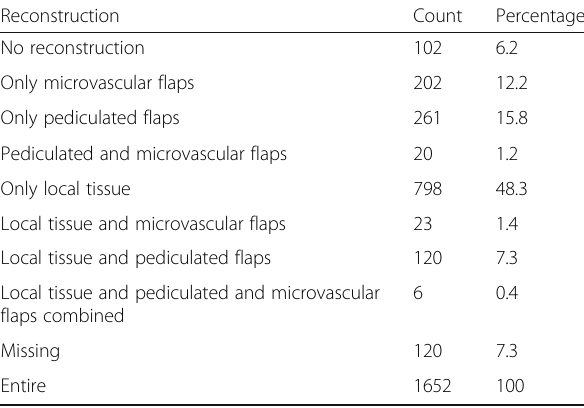
Table 5 Frequency and type of reconstruction after surgical treatment of oral cancer Reconstruction